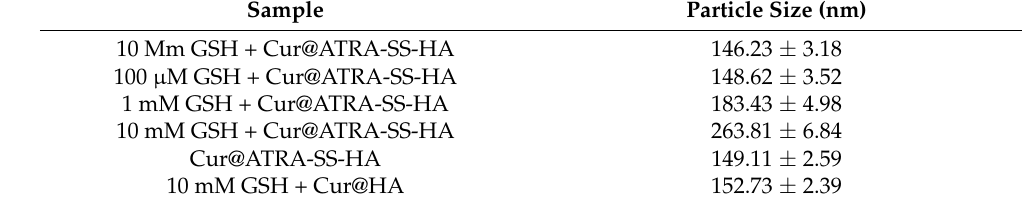
Table 3. Sensitivity of Cur@ATRA-SS-HA and Cur@HA to GSH.